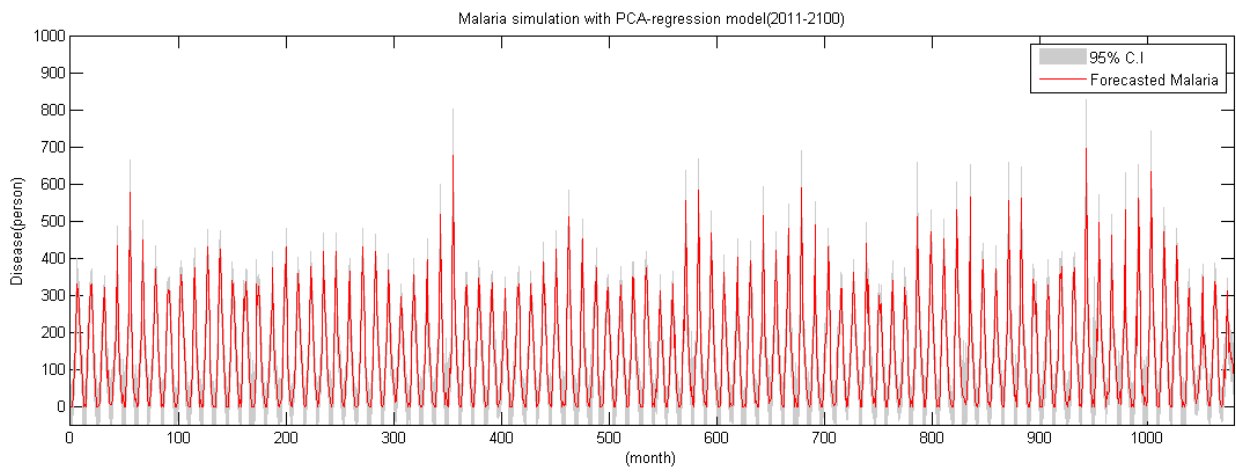
Figure 8. Simulated malaria time series